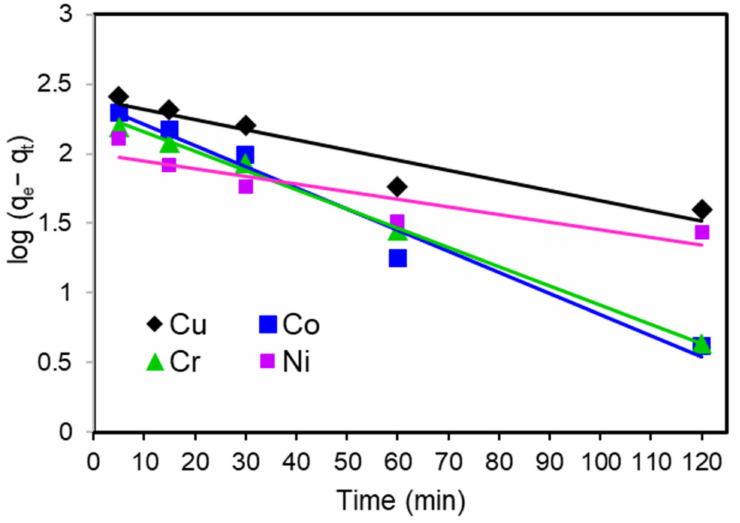
Figure 4. Pseudo-first order kinetic plots of heavy metal ions by poly(amidoxime) ligand; experimen- tal conditions. Table 1. Pseudo-first order rate of sorption of heavy metal ions by poly(amidoxime) ligand.